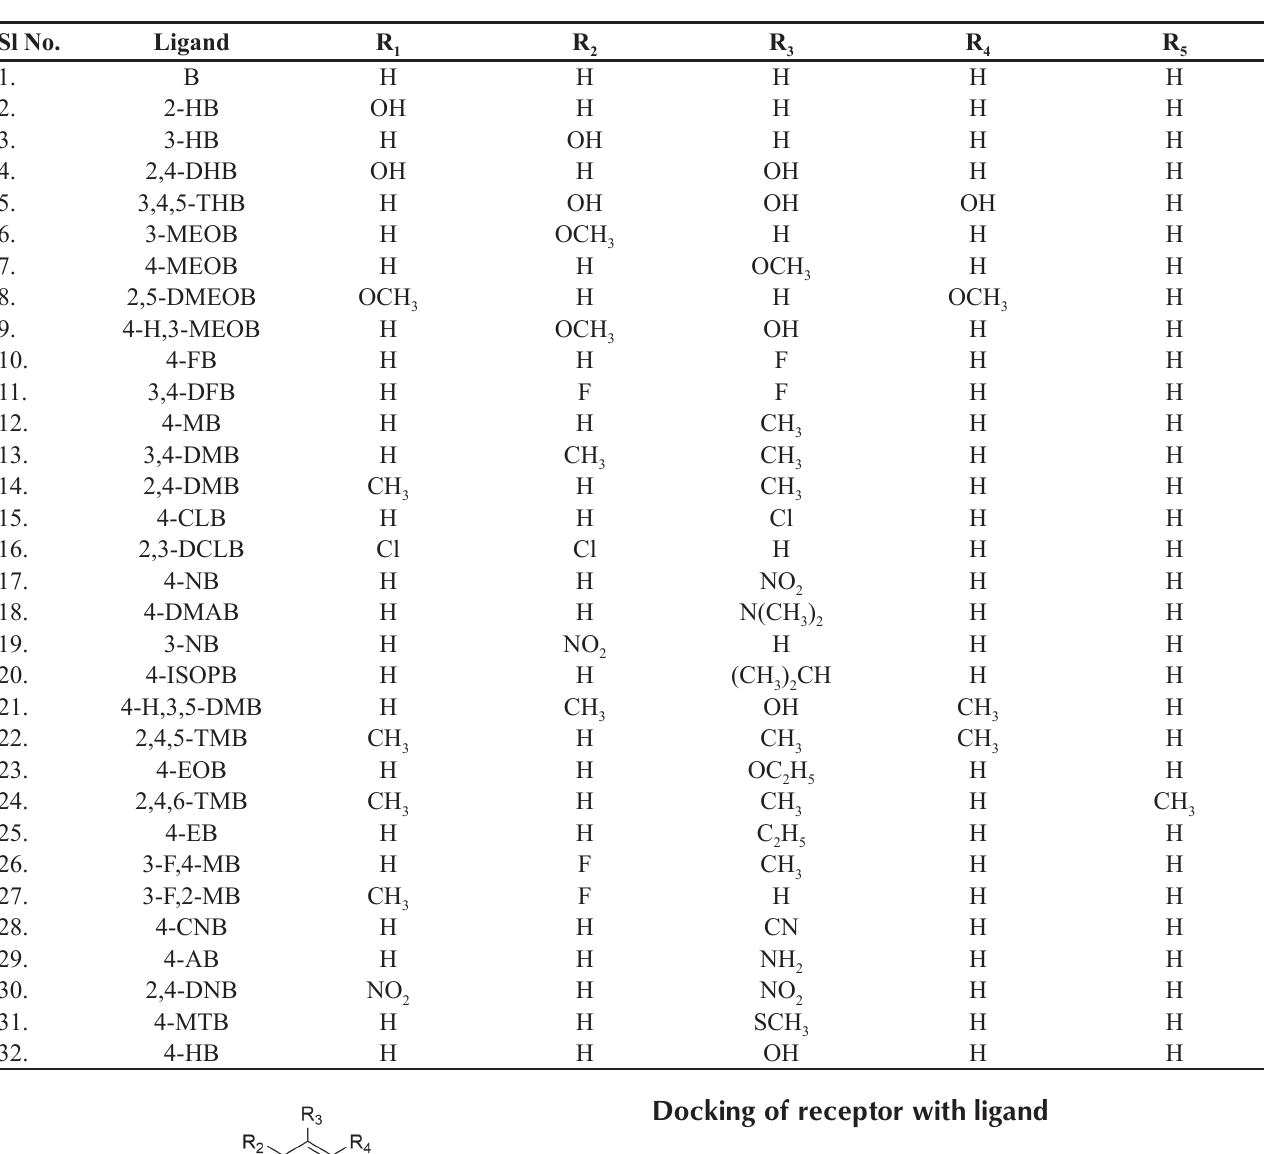
TABLE I - Data set of compounds used for docking study Sl No.